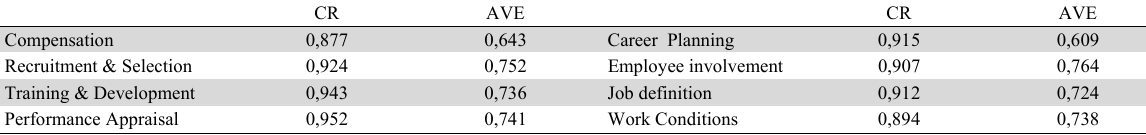
Construct Validity Results of HRM